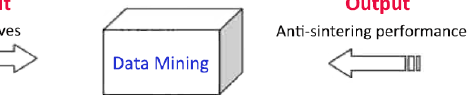
Figure 2. Input, output and process of modeling.